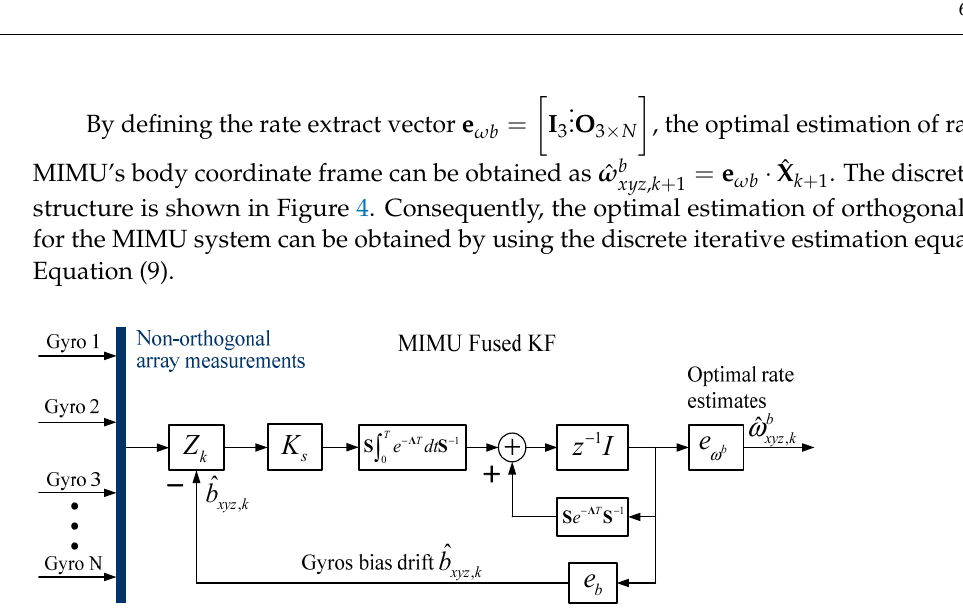
Figure 4. Redundant MIMU signal fusion using a discrete-time KF implementation.